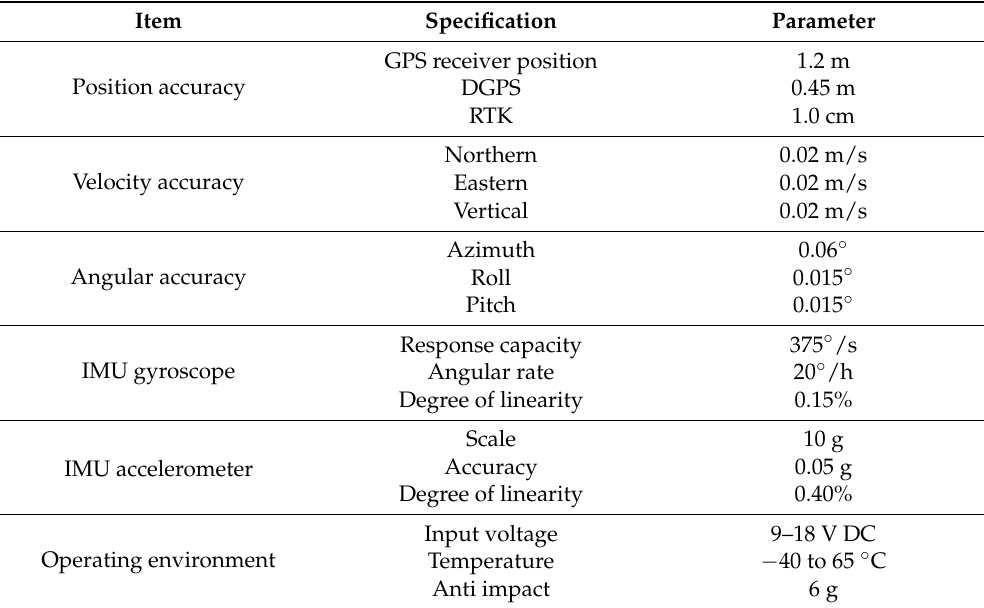
Table 4. Technique parameters of the GPS/INS device.